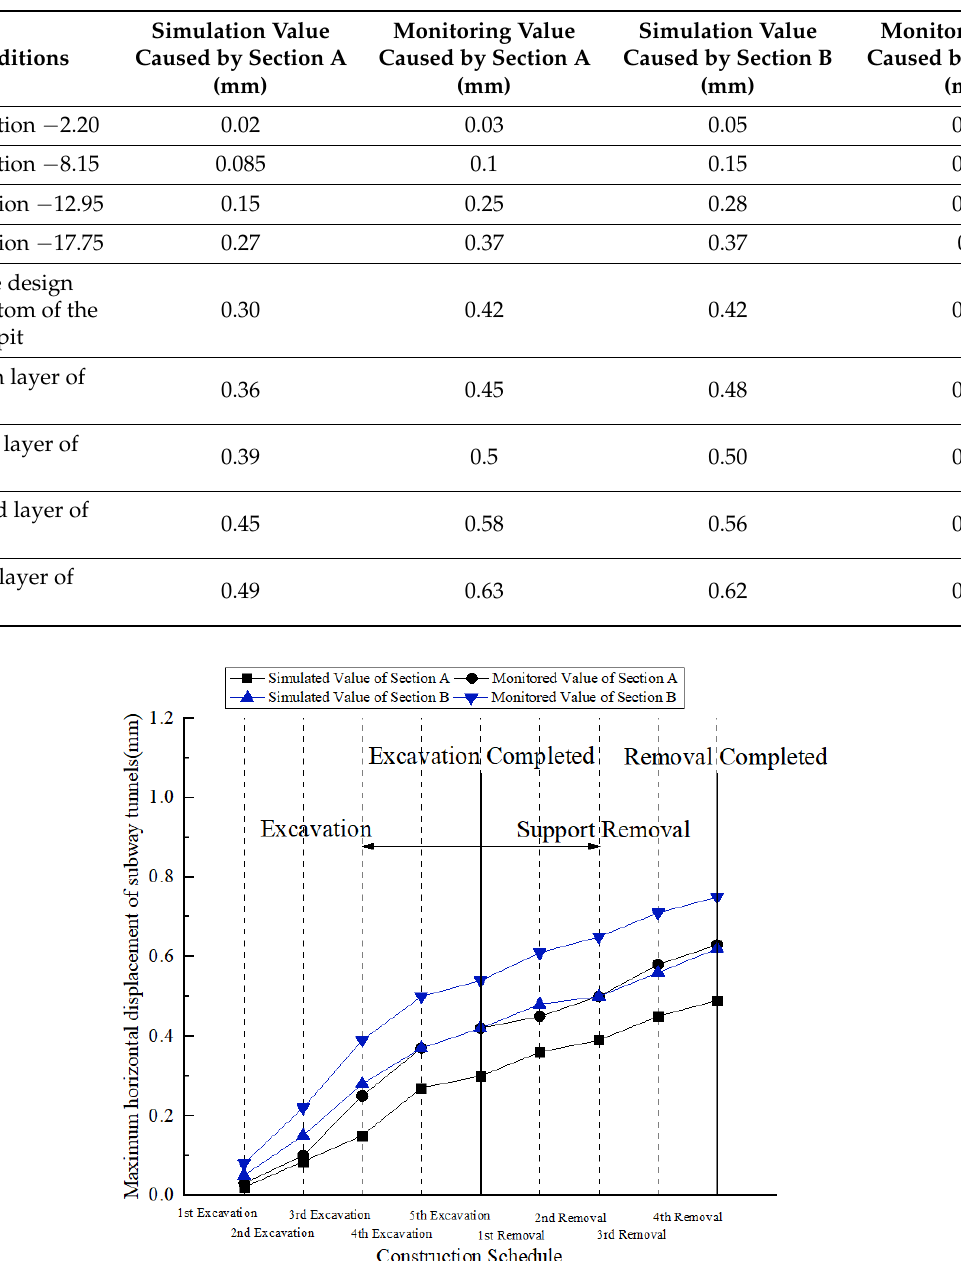
Table 5. Maximum horizontal deformation of subway tunnel caused by pit construction.